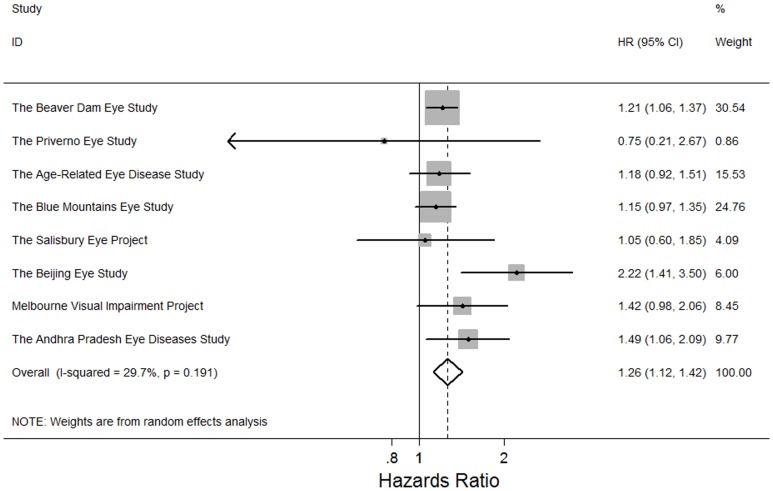
Random effects meta-analysis investigating the association between cortical cataract and all-cause mortality.HR = hazards ratio; CI = confidence interval.